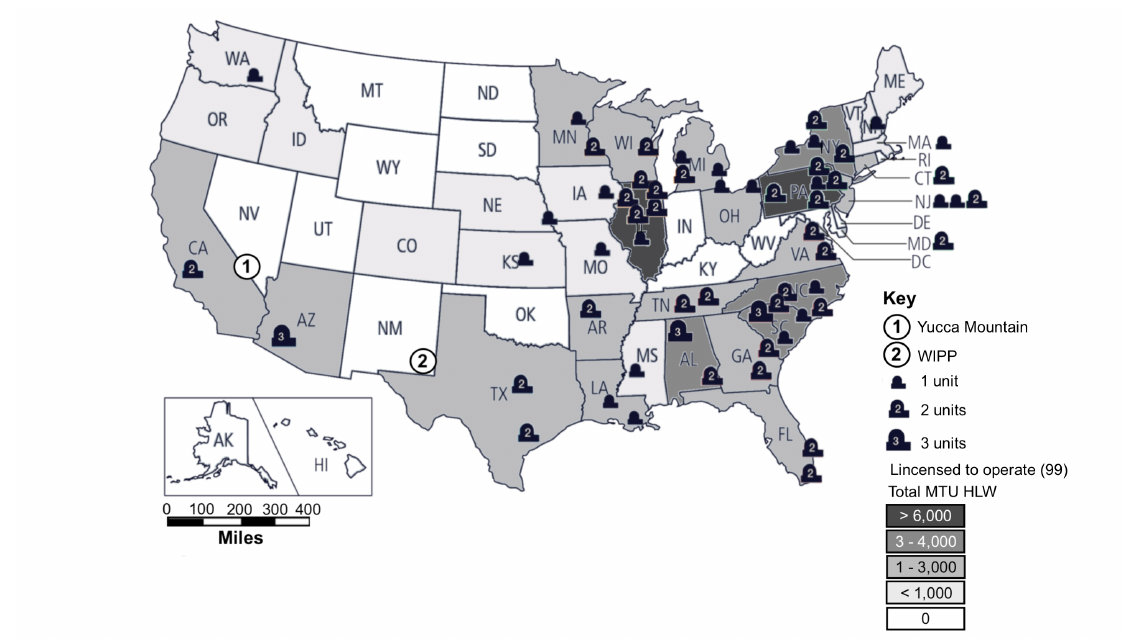
Figure 1. Regional distribution of high-level nuclear waste and nuclear power plants in the U.S. (source: own representation based on [2,16,17], and own